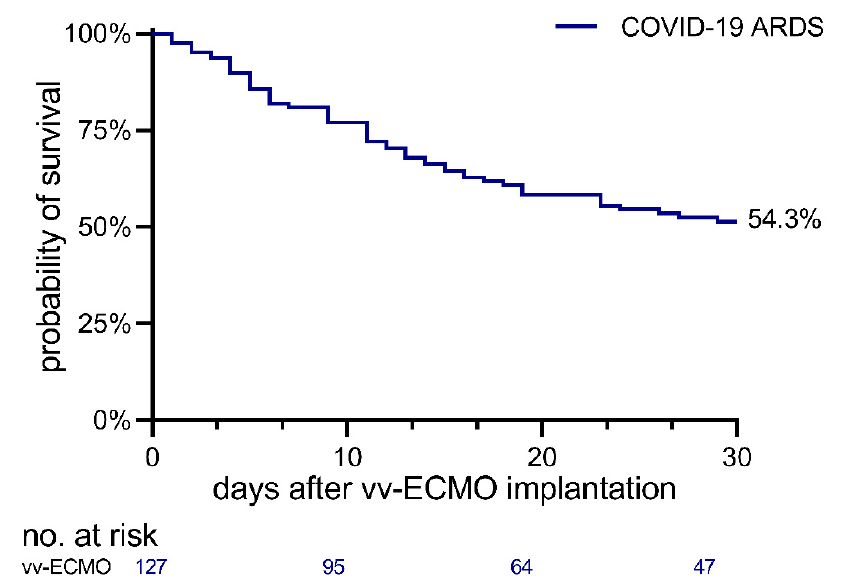
Figure 2. Kaplan–Meier curve displaying the survival over the course of the 30-day study period in the entire cohort. Table 2. Patient baseline (before initiation of extracorporeal membrane oxygenation therapy (ECMO)) characteristics as well as results for Sequential Organ Failure Assessment (SOFA), Simplified Acute Physiology Score II (SAPS II), Acute Physiology And Chronic Health Evaluation II (APACHE II), Respiratory Extracorporeal Membrane Oxygenation Survival Prediction (RESP), and Predicting Death for Severe ARDS on V-V ECMO (PRESERVE) scores in all patients and in survivors and non-survivors independently (median, IQR). The impact of continuous and categorical baseline characteristics on 30-day survival was evaluated using Chi-square and Mann–Whitney